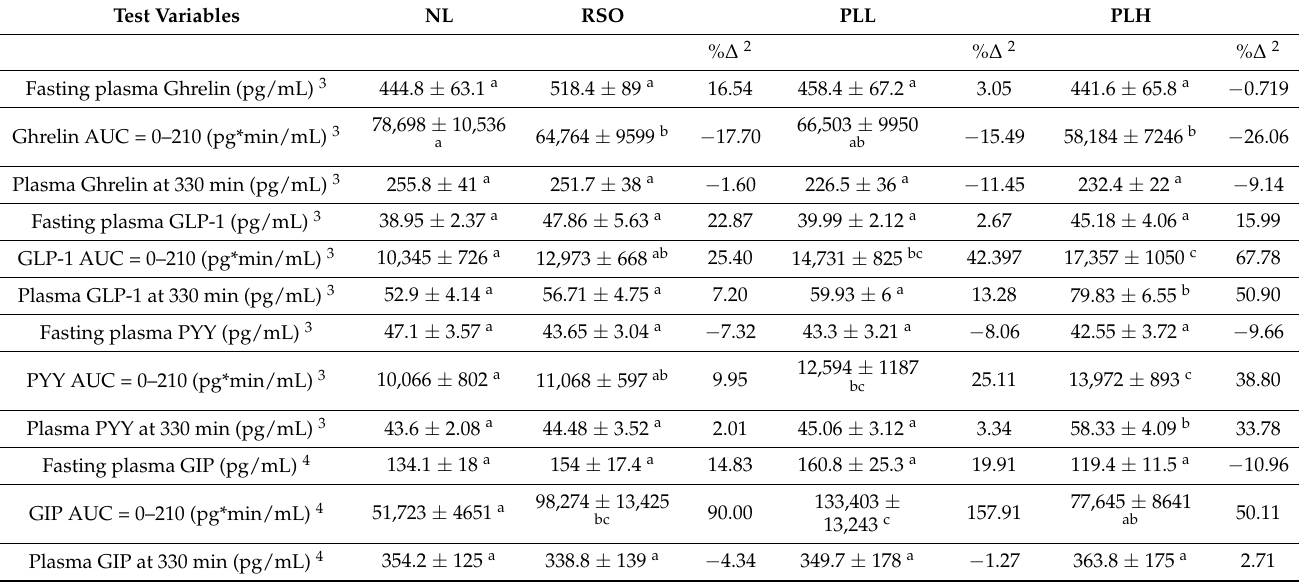
Table 5. Plasma GLP-1, PYY, Ghrelin, and GIP response after breakfast and lunch 1 .